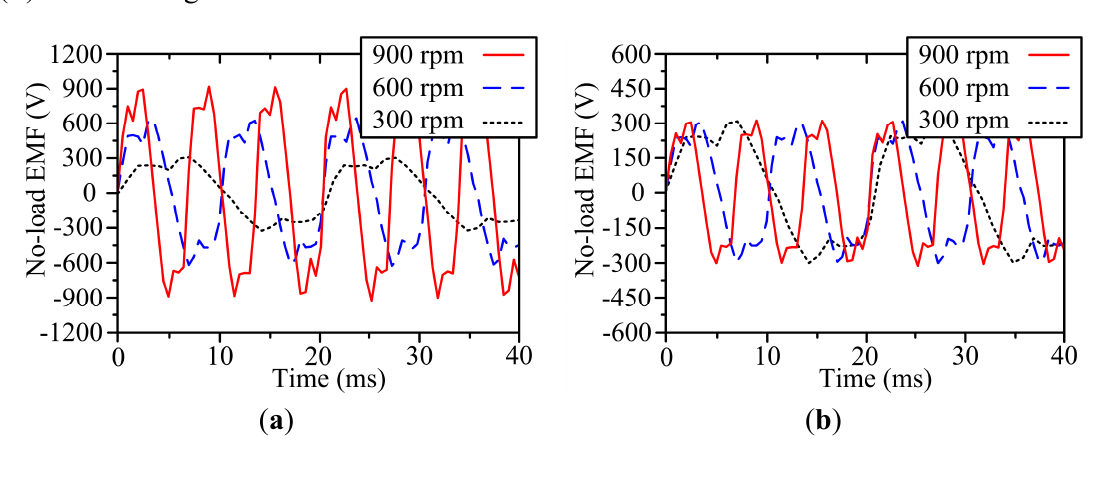
Figure 15. No-load EMF waveforms at various speeds: ( a ) without flux regulation; and ( b ) with flux